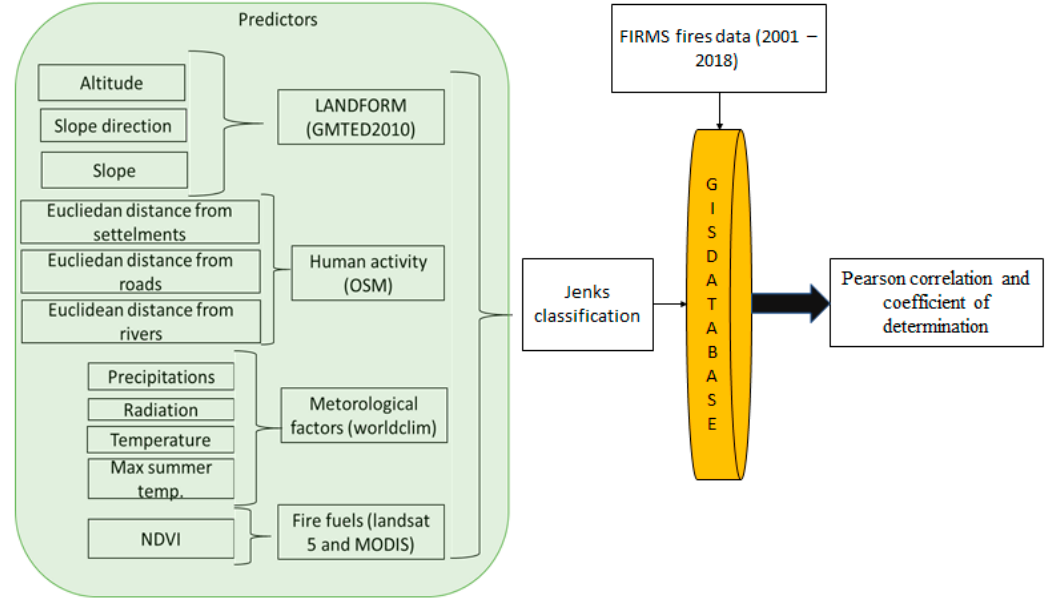
Figure 2. Schema of the analysis of the relationship between the fires and their factors.